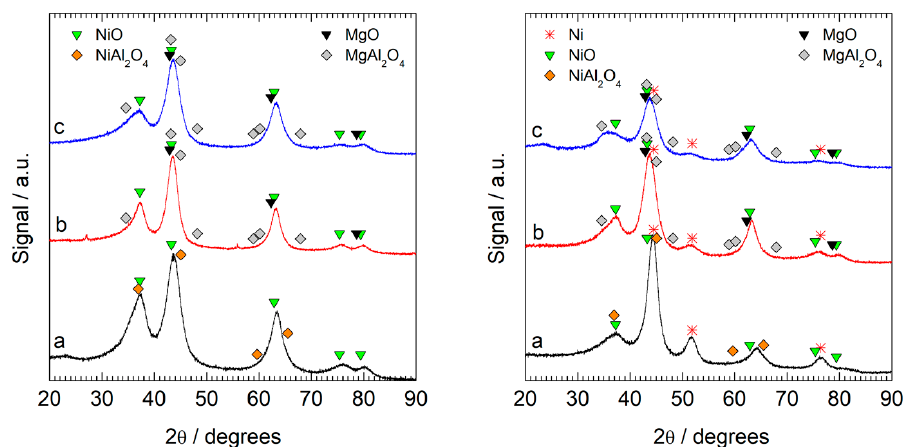
Figure 3. XRD patterns of the LDH precursors calcined at 400 °C for 4 h ( left ) and the catalysts after